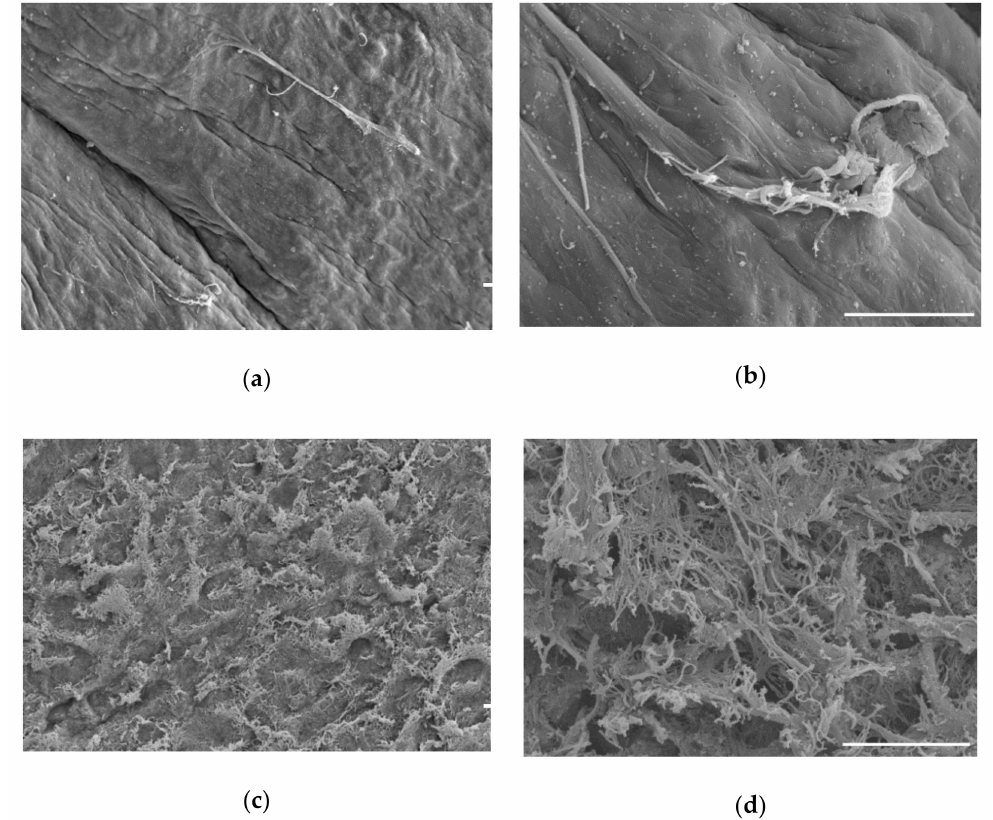
Figure 5. Visualization of cartilage by scanning electron microscopy. ( a ) Cartilage prior to treatment; ( b ) higher magnification of cartilage prior to treatment, where the tissue appears smooth and intact; ( c ) final decellularized cartilage disc; ( d ) higher magnification of decellularized cartilage disc. Ap- pearance after decellularization indicates a rough surface with increased surface area and exposed collagen fibrillar networks. Scale bars = 20 µ